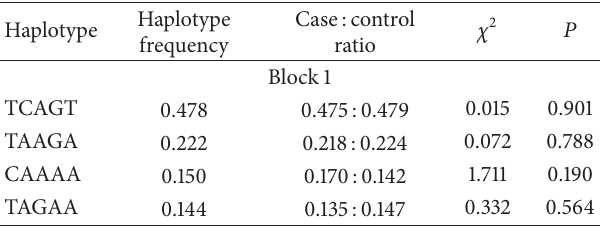
Table 4: Comparison of haplotype frequencies for the analysed NR3C1 polymorphisms between patients with suicide attempts and the control group.